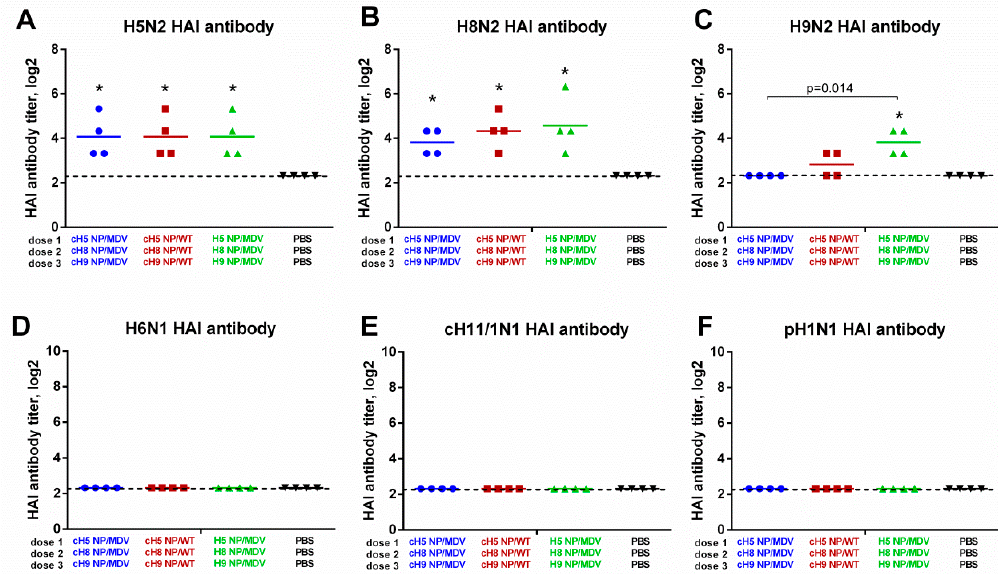
Figure 5. HAI antibody immune responses in immunized ferrets measured against a panel of viruses. ( A ) H5 NP / MDV LAIV. ( B ) H8 NP / MDV LAIV. ( C ) H9 NP / MDV LAIV. ( D ) A / herring gull / Sarma / 51 / 2006 (H6N1) wild-type virus. ( E ) cH11 / 1N1 LAIV virus bearing chimeric HA gene (the HA stalk domain of Cal09 and the HA head domain of A / northern shoveler / Netherlands / 18 / 99 (H11N9)) and the NA gene of Cal09. ( F ) A / South Africa / 3626 / 2013 (pH1N1) wild-type virus. The HAI titers for H5 and H8 antigens were determined using horse red blood cells; the remaining antigens were tested with chicken RBCs. * indicates significant di ff erence with the mock-vaccinated group. The dashed line indicates the limit of